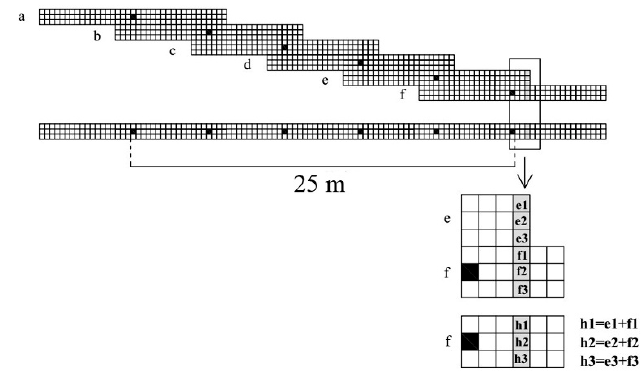
Figure 6. Calculation diagram of the distribution of combined sprinkler intensity. Sprinklers are spaced 5 m apart.